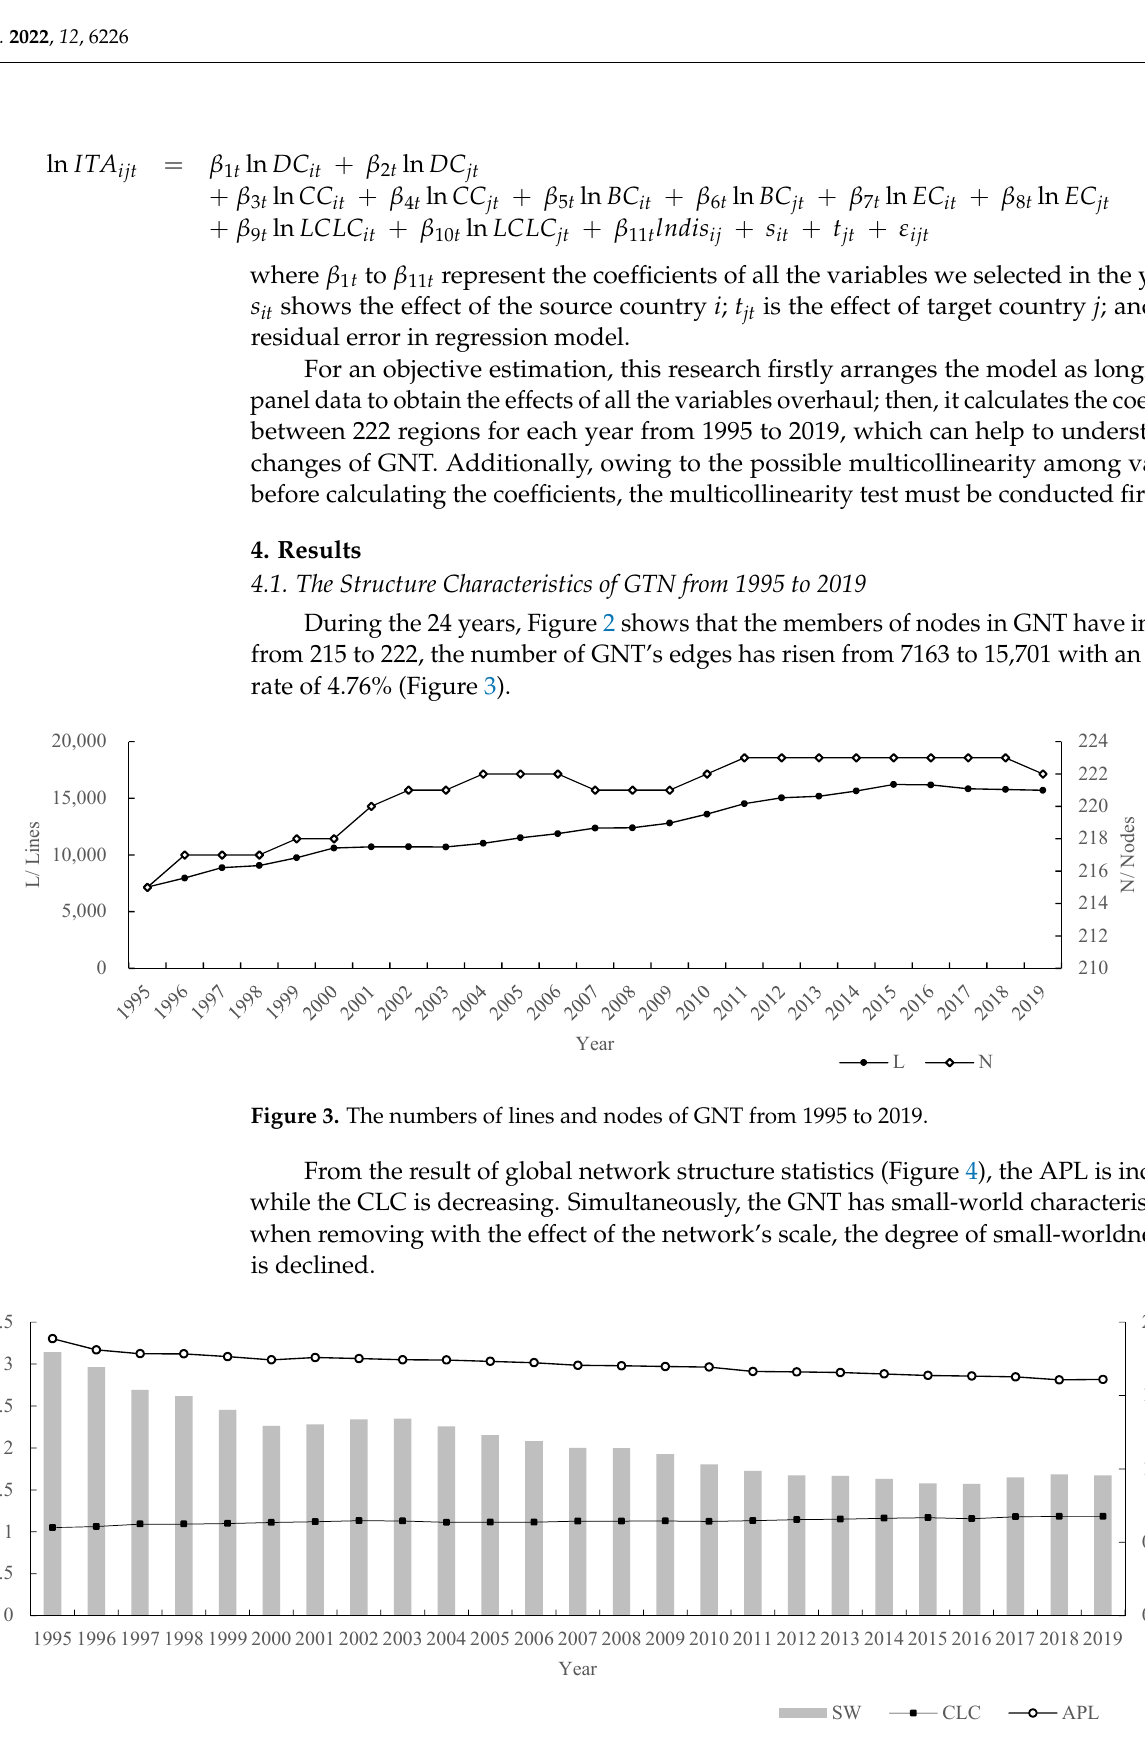
Figure 4. The CLC, APL and σ of GNT from 1995 to 2019. The global performance indicates that AITA changes from 1995 to 2019. From Figure